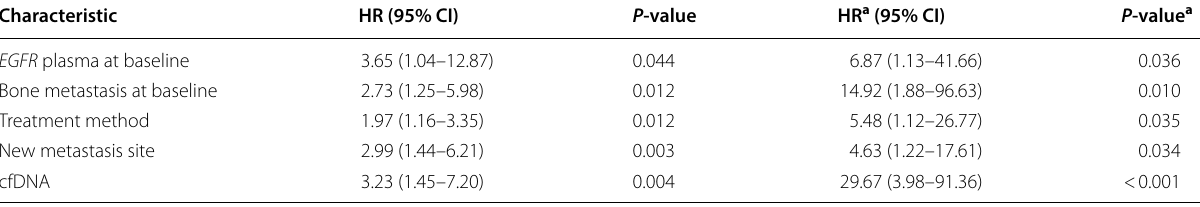
a For the newly diagnosed group